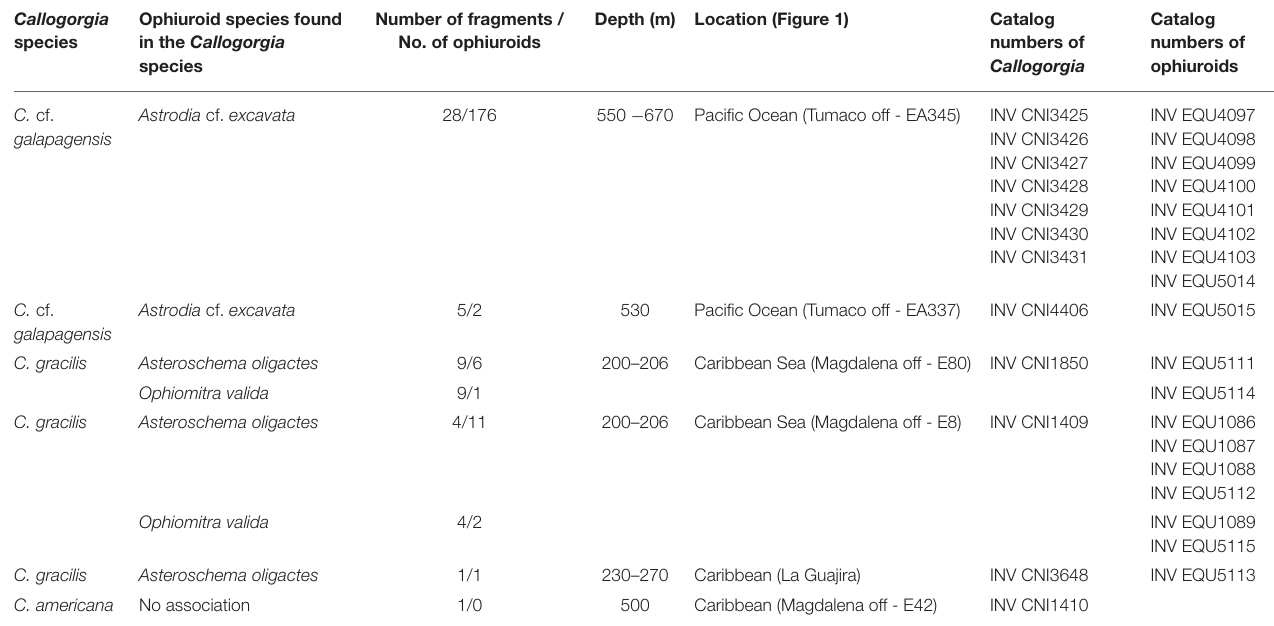
TABLE 1 | Commensal relationship between Callogorgia spp. and ophiuroids found in the Colombian Pacific and Caribbean Sea based on material deposited in the Marine Natural History Museum of Colombia (MHNMC) of INVEMAR. Callogorgia Number of fragments / Depth (m) Location (Figure Ophiuroid species found No. of ophiuroids species in the Callogorgia species